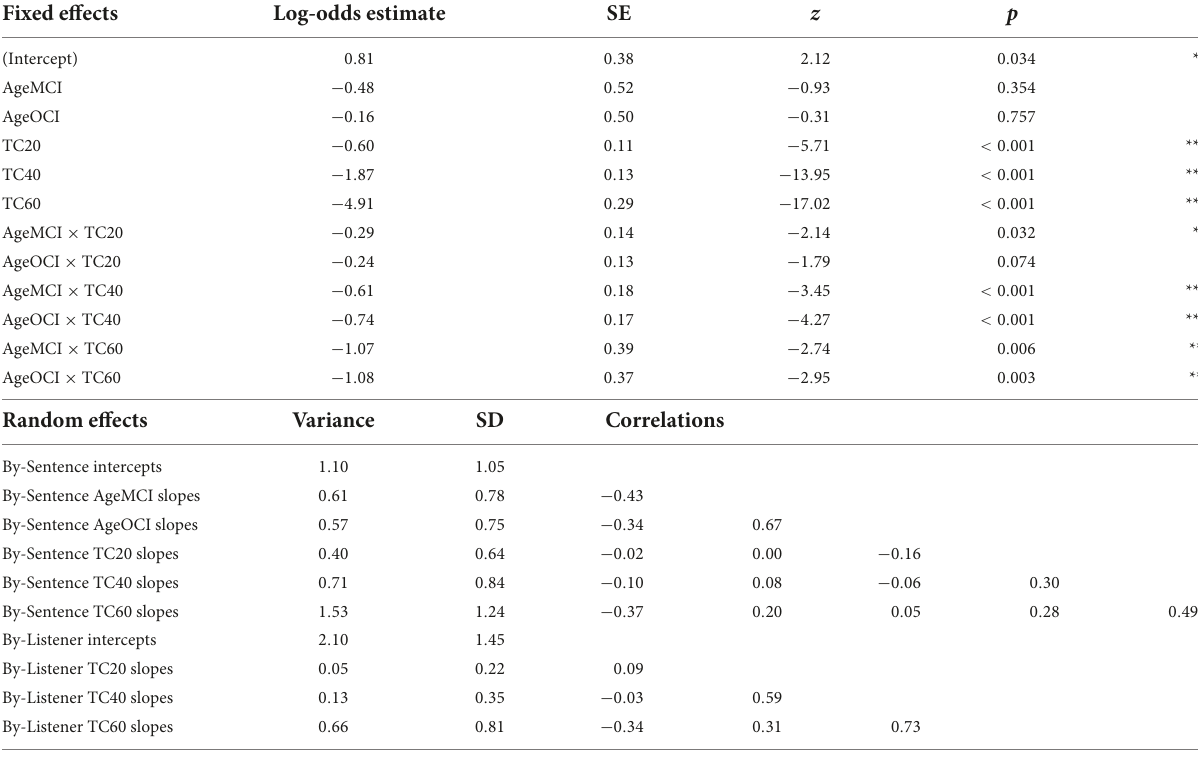
TABLE 3 Logistic mixed-effects model describing the effects of experimental variables and other predictors on speech recognition performance of listeners with CIs. Fixed